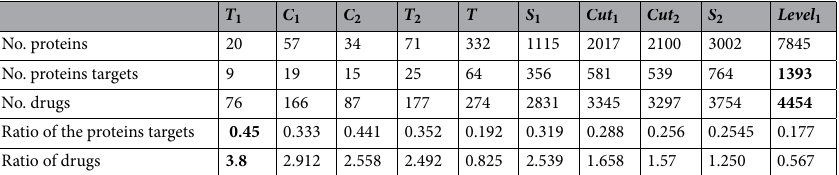
Table 5. The summary of drug targets and related drugs for All-Drug group. The first row shows the size of T C C T S Cut Cut S Level 1 , 1 , 2 , 2 , T , 1 , 1 , 2 , 2 , 1 sets. The number proteins targets and related drugs in each set for All-drug group are reported in second and third rows, respectively. The fourth and fifth rows show the ratio of the number of proteins that targeted and their related drugs in each set for All-drug group to the size of sets, respectively. The complete description of sets is presented in Table